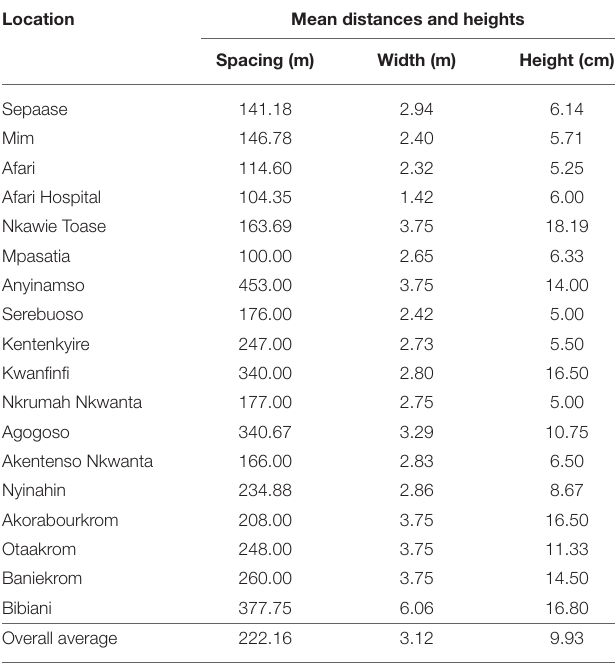
TABLE 1 | Characteristics of speed calming measures on Abuakwa-Bibiani road.